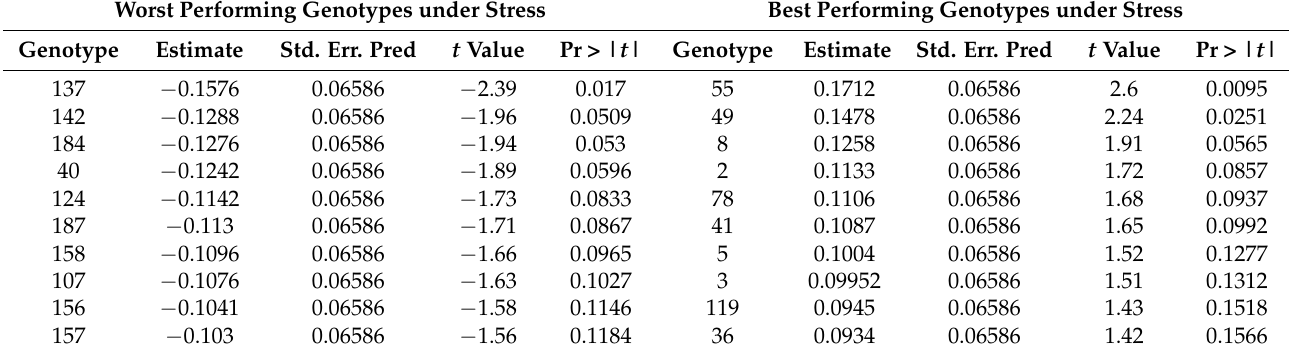
Table 8. The performance of genotypes under